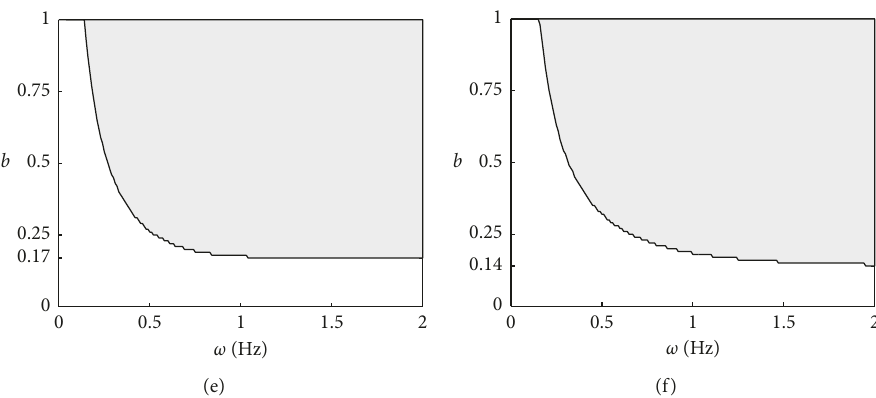
Figure 4: Mean square stability charts to equation (8) for the values η